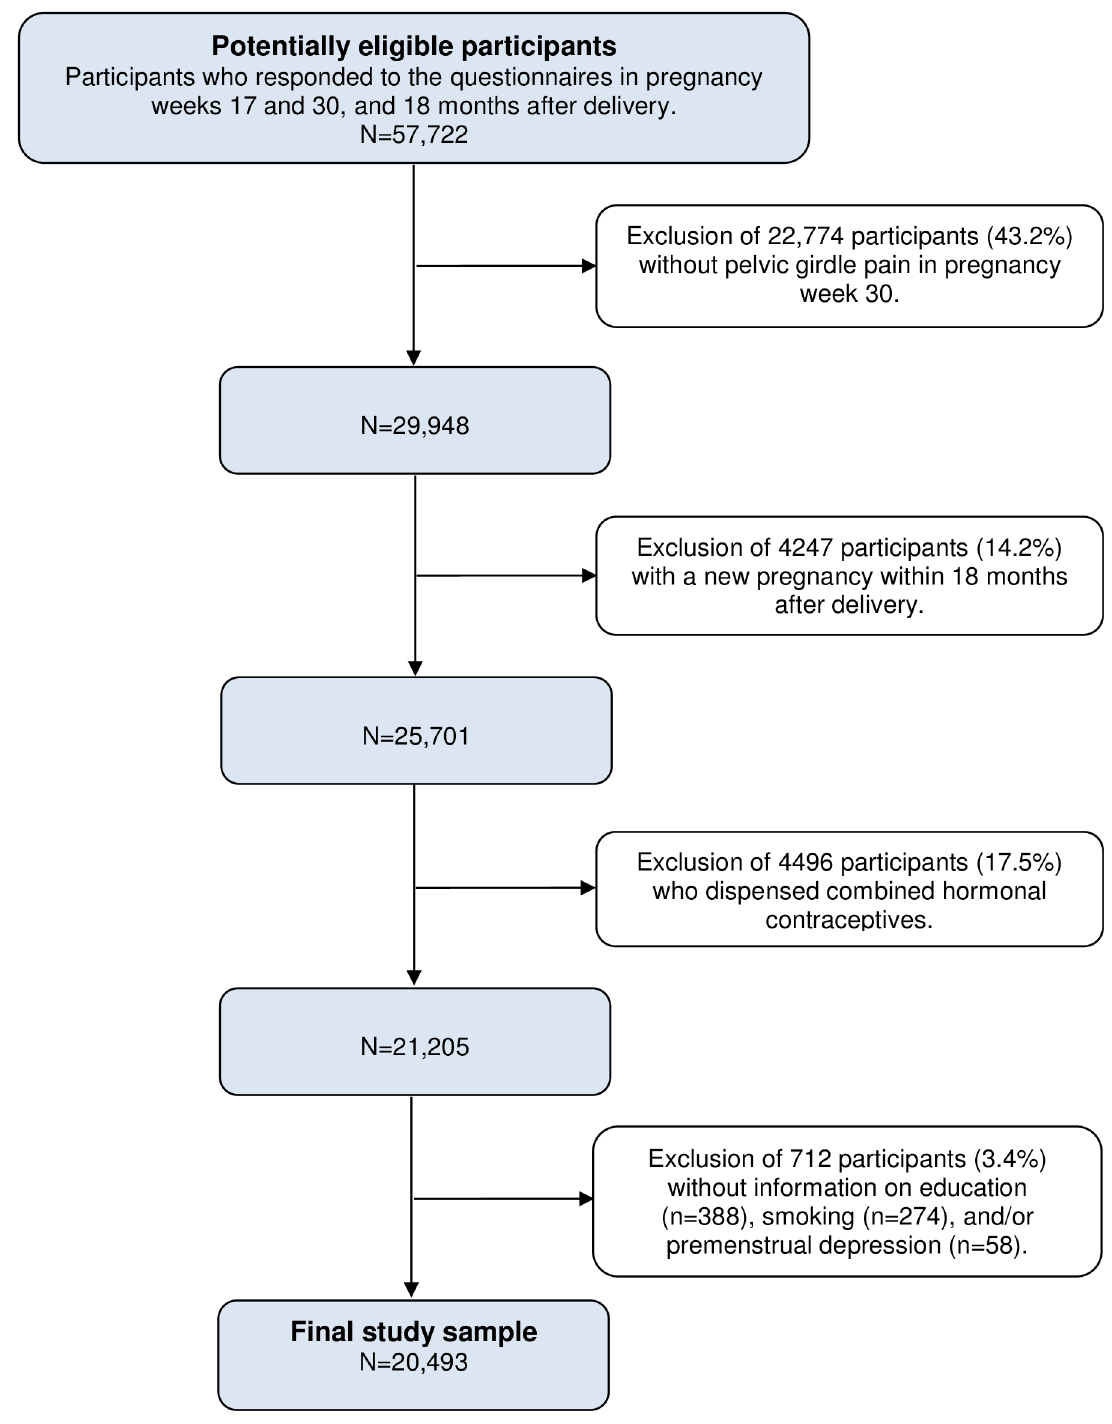
Fig 1. Flow chart of the study sample (2003–2011).